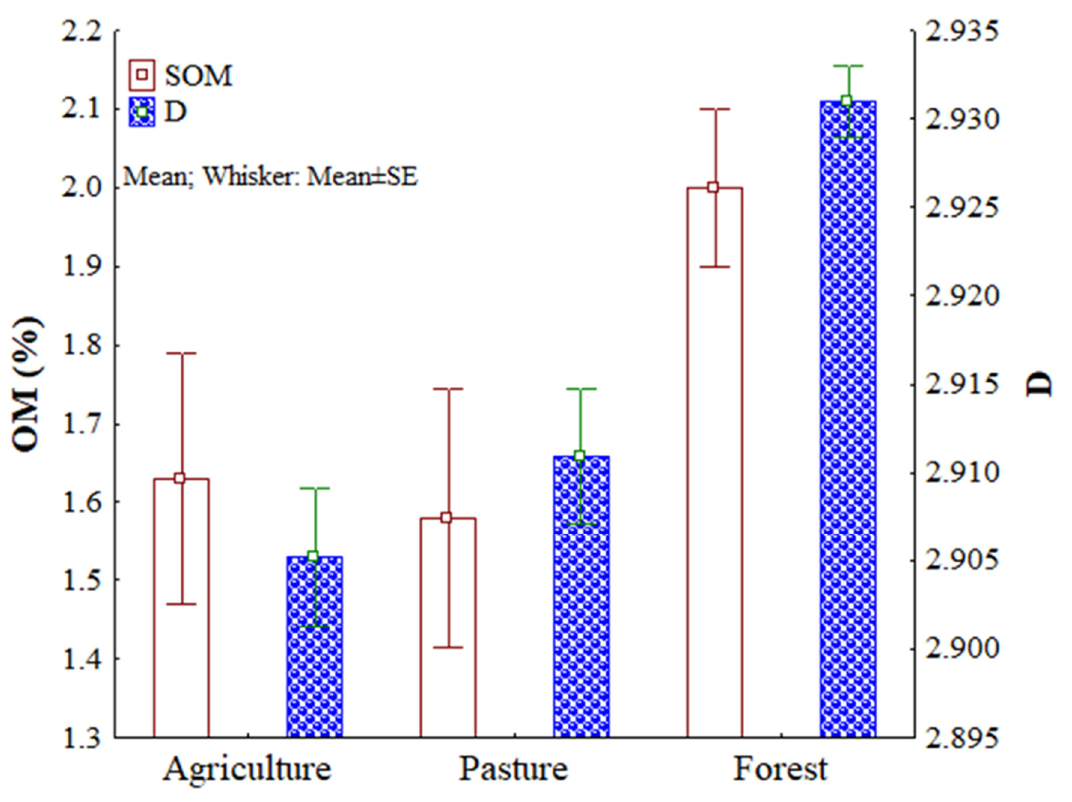
Figure 6. The fractal dimension of soil particle size (D) and soil organic matter (SOM) in different types of land use.